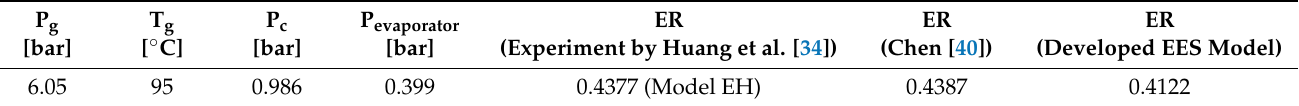
Table A3. Comparison of the results of developed EES model and results reported by Huang et al. [34] and Chen [40]. P g